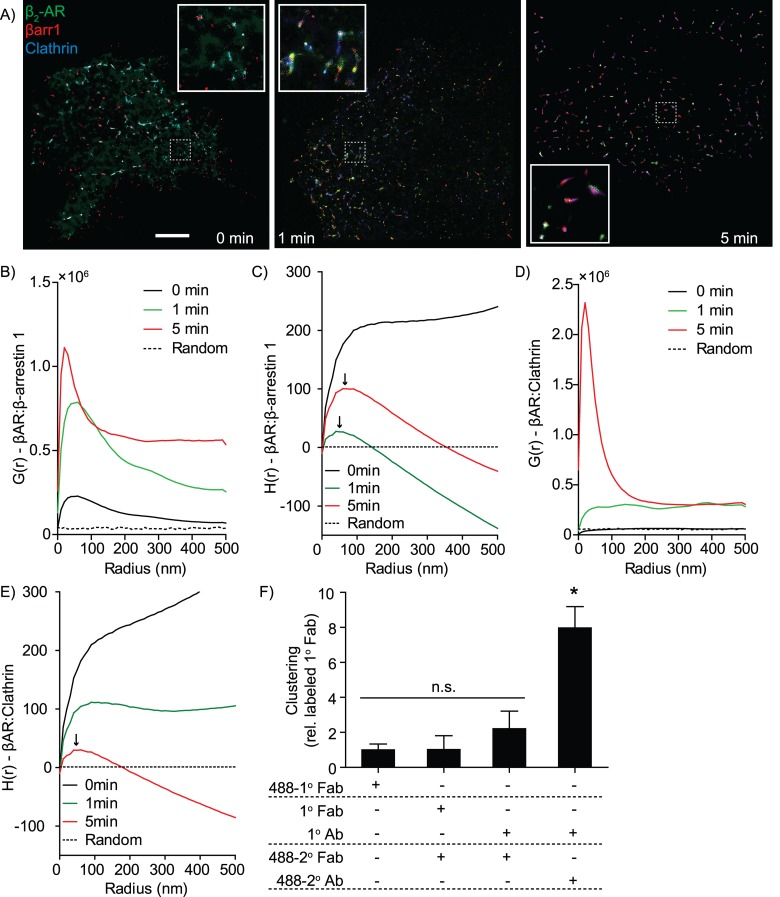
Quantifying co-clustering using the radial distribution function and Ripley’s K function.(A) The β2-adrenergic receptor (β2-AR, Green), β-arrestin-1 (βarr1, Red) and Clathrin (Blue) form an internalization complex after stimulation of the β2-adrenergic receptor in HEK293 cells with 10 μM isoproterenol. (B-C) Quantification of co-clustering of the β2-adrenergic receptor with β-arrestin-1 by (D) RDF analysis and (E) Ripley’s H-function, before (0 min) and 1 and 5 minutes post-stimulation with isoproterenol. (D-E) Quantification of β2-adrenergic receptor co-clustering with clathrin coated pits by (D) RDF analysis and (E) Ripley’s H-function, before (0 min) and 1 and 5 minutes post-stimulation with isoproterenol. (F) Self-clustering of the tetraspanin CD81 induced by the use of polyvalent versus mono/divalent labeling reagents. Ab = antibody. All images are representative of, and graphs quantify, 3 experiments with a minimum of 5 images per experiment. Data are presented as mean ± SEM, * = p < 0.05, n.s. = not significantly different, ANOVA with Bonferroni correction. Scale bar (A) is 2.5 μm, inserts are 1.47 μm x 1.47 μm. D-E: Arrows indicate mean cluster size, as determined by the radius of maximum H(r).